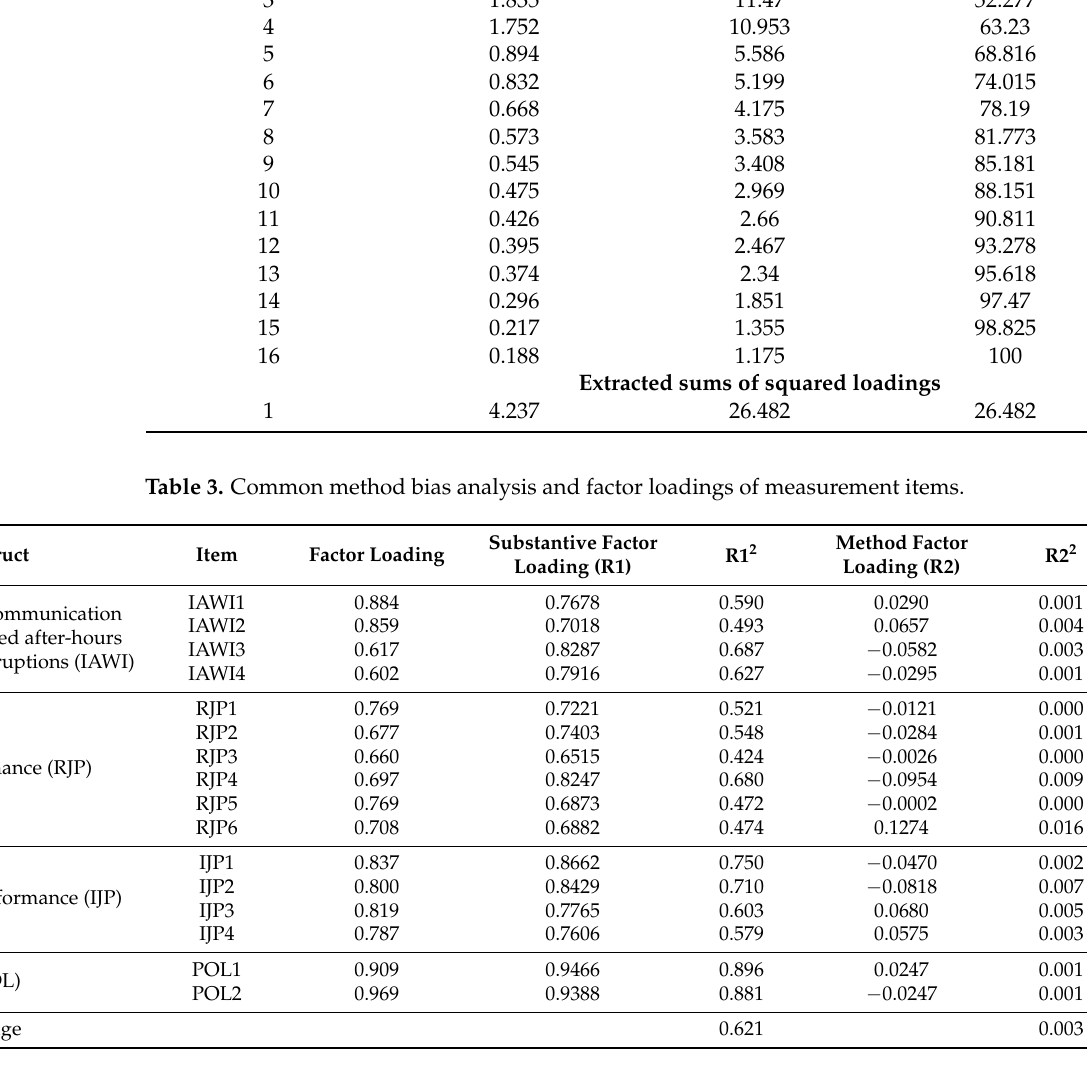
Table 4. Means, standard deviations, Cronbach’s α , CR, AVE, and construct